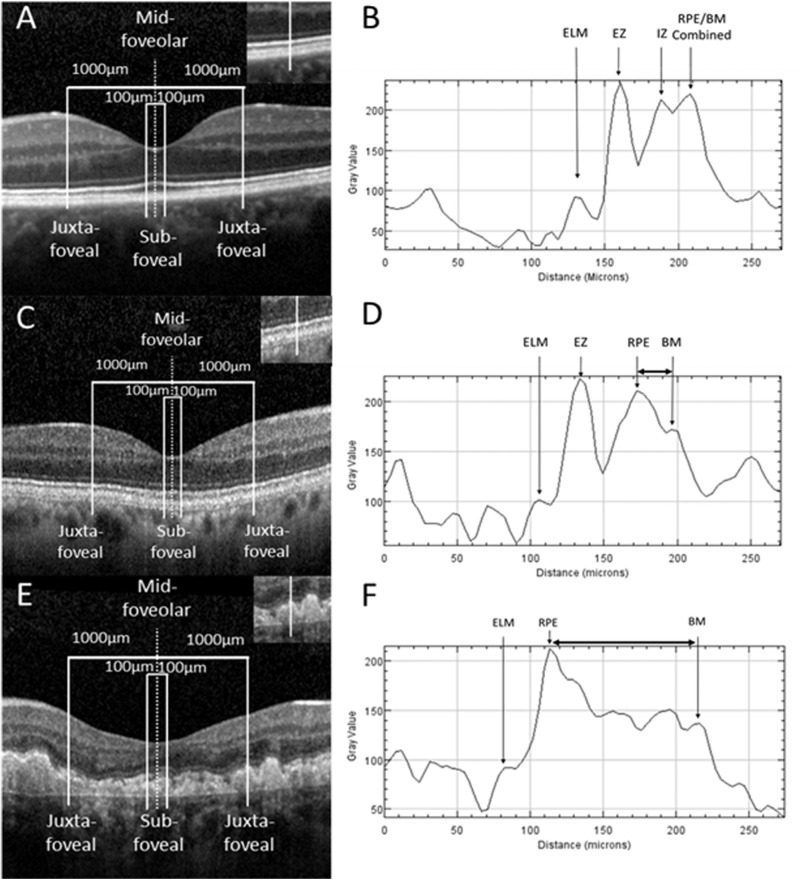
OCT scans and plot profile measurements of BM-RPE separation. Examples are shown for a normal control (A, B), an early-stage dystrophic eye with L-ORD (C, D), and a late-stage case of DD (E, F). A horizontal Spectralis SD-OCT line scan through the central fovea was analyzed for each eye of every patient and control. Readings were taken 100 µm either side of the foveola for subfoveal measurements, and 1000 µm either side of the central fovea for juxtafoveal measurements (A, C, E). A line was generated across the outer retina. The insets show the representative lines that were used to generate the intensity plot profiles at the farthest right juxtafoveal location (B, D, F). Intensity plot profiles across the outer retina highlight the position of the ELM, EZ, IZ, RPE, and BM. The horizontal arrows highlight the BM to RPE separation in the case plot profiles (D, F).